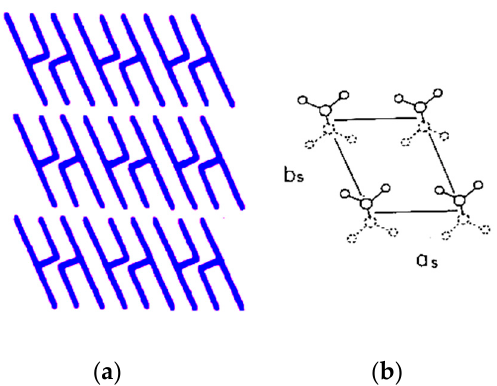
Figure 4. Schematic representation for the β phase of monoacid triacyl glycerols (TAGs). ( a ) Molecules form a double-chain-layered structure, whose interface is parallel to the flat surface of thin plate single crystals. ( b ) Acyl chains in the β phase form the T// sub-cell structure.